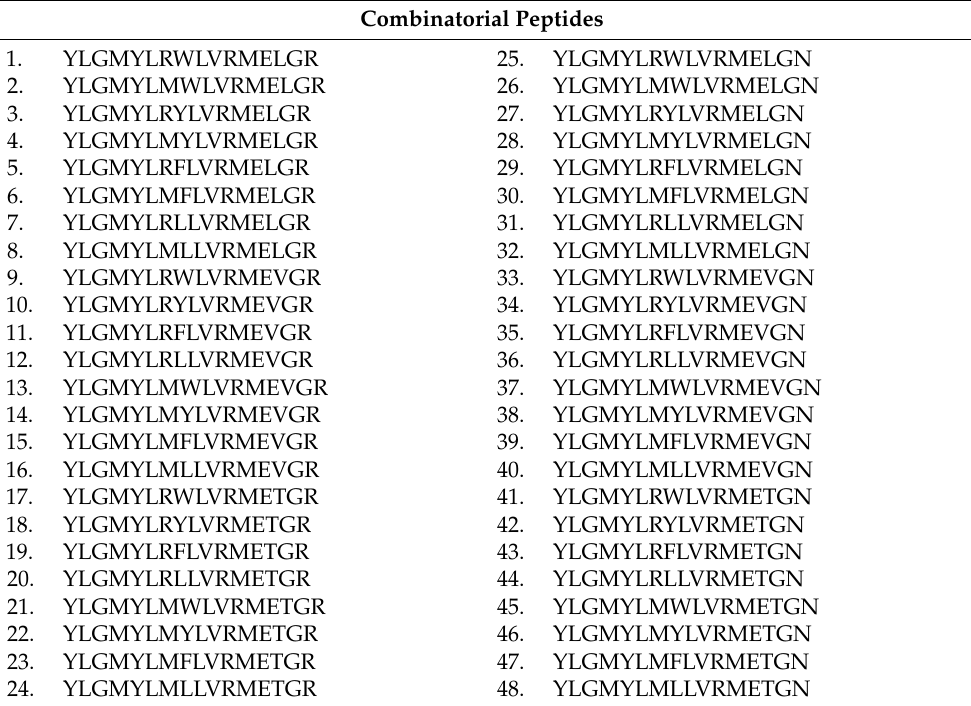
Table 7. Combinatorial peptides designed based on computational residue scanning performed on the 3 10 -HBS RB3 peptide and MM-GBSA calculations on MD